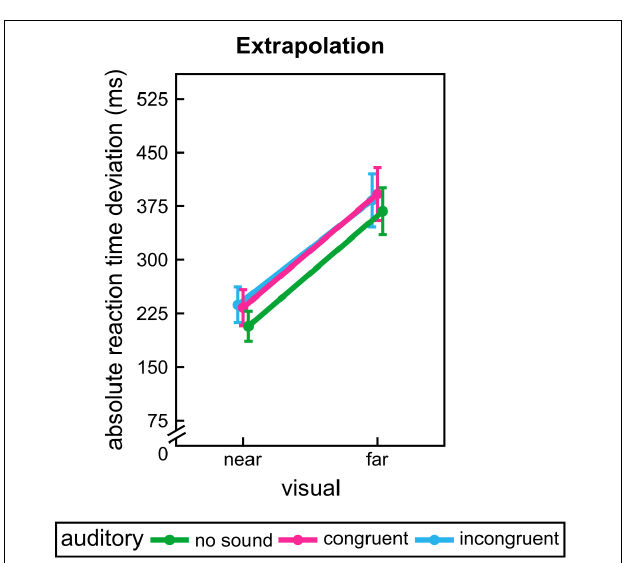
FIGURE 4 | Group mean results of experiment 2. Absolute reaction time deviations for each visual and sound conditions during extrapolation. Error bars show the standard error of the mean. Points are offset horizontally so that all error bars are visible.